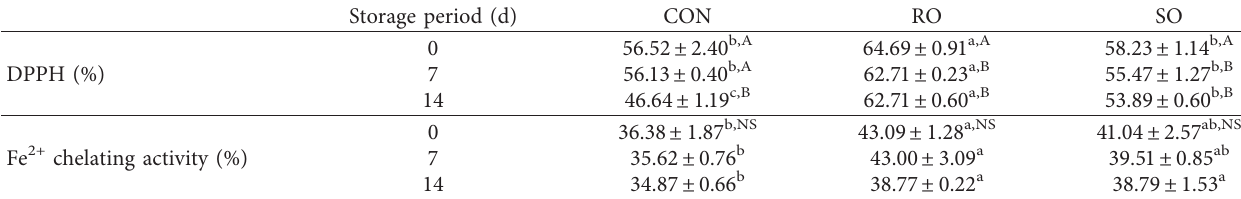
Table 4: Antioxidant activities during the storage of yogurts.